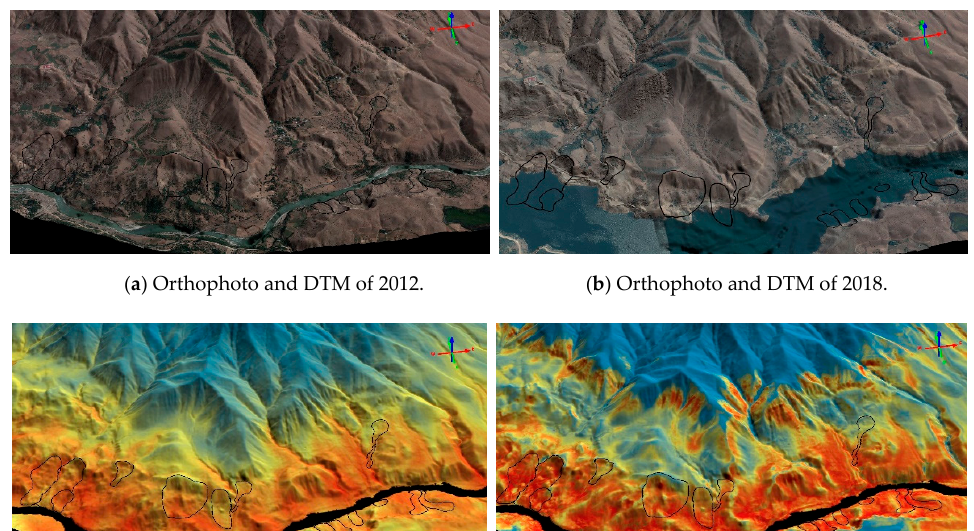
Figure 14. The ortophotos ( a , b ), ML outputs ( c – e ), and plots of the Euclidian differences ( f – g ) obtained